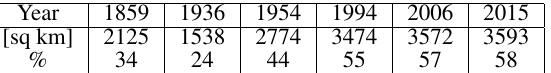
Table 7. Forest coverage evolution in the Trentino region from 1859 to 2015.